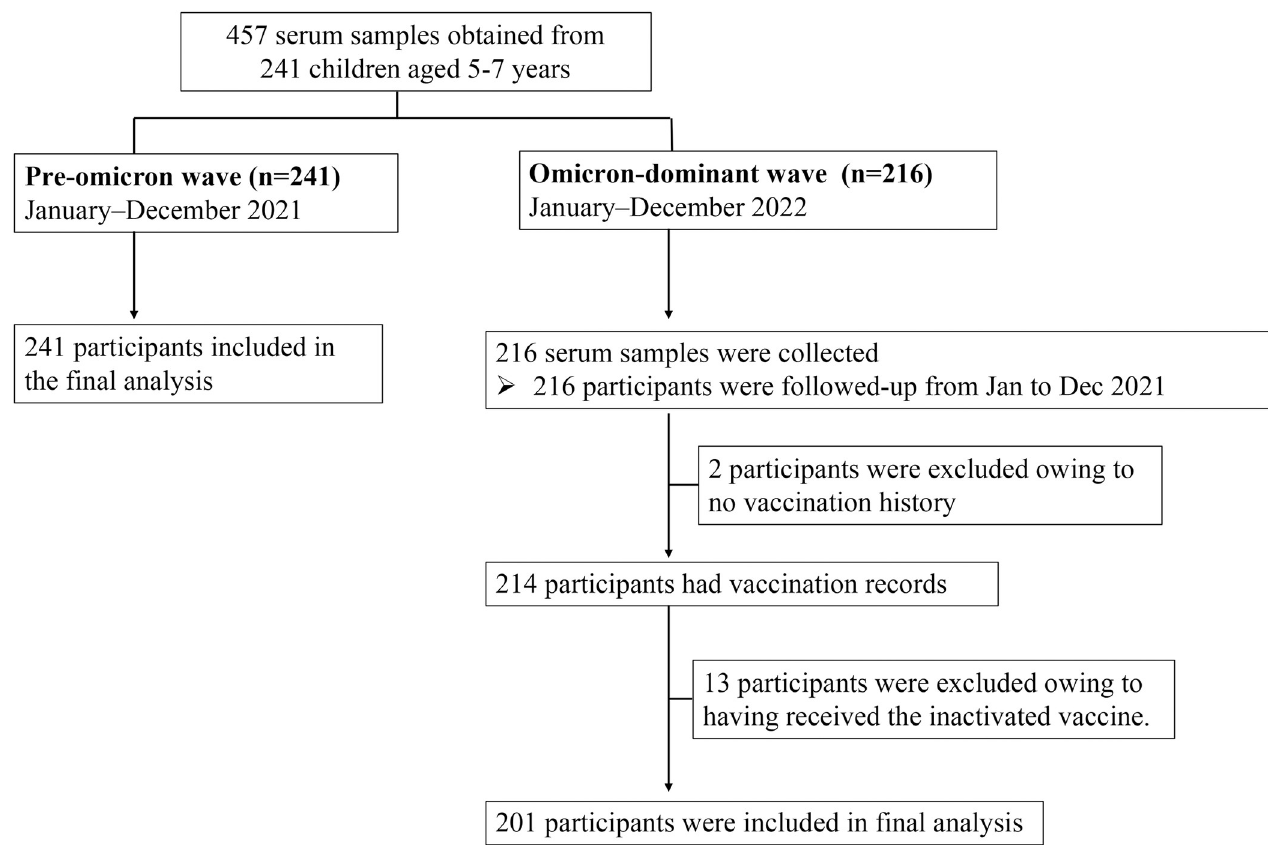
Fig 1. Recruitment of